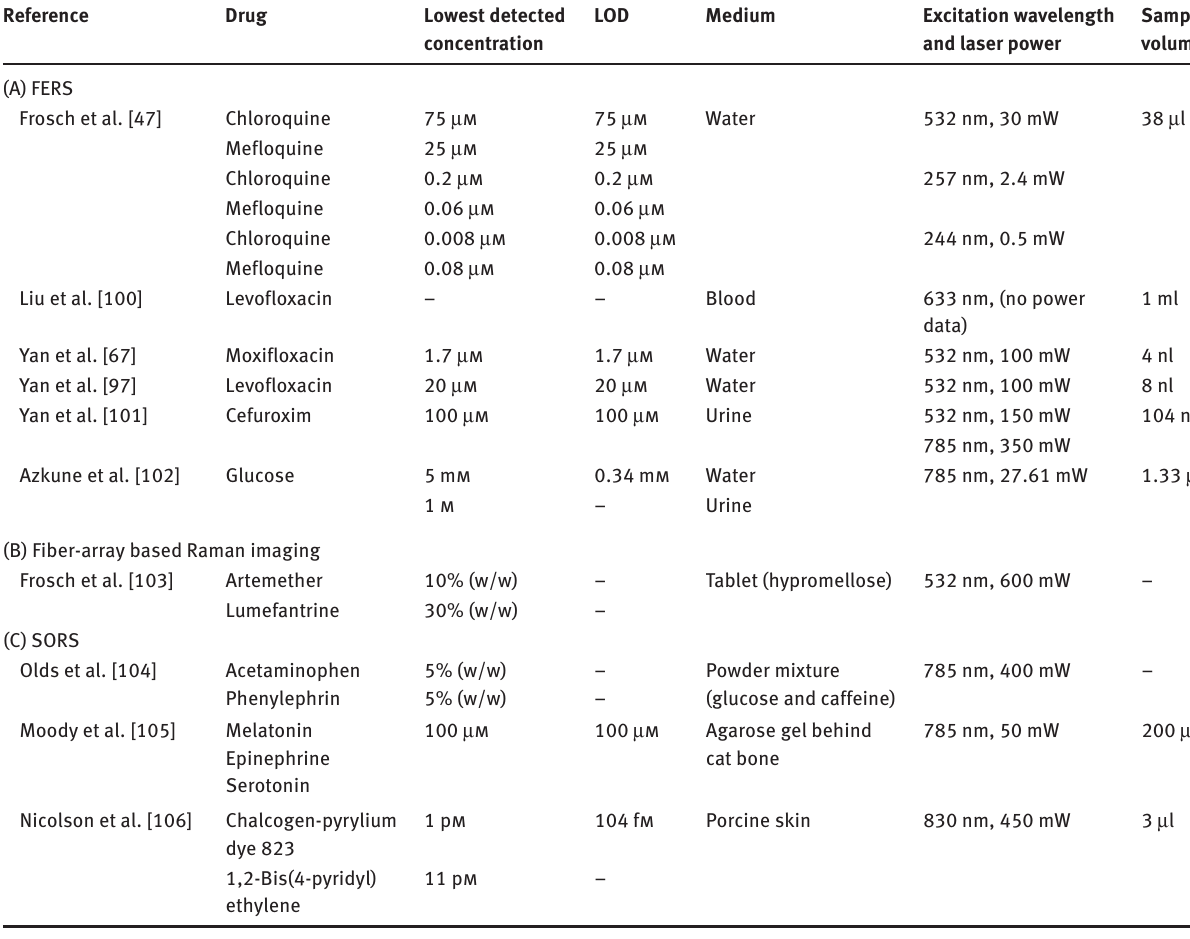
Table 2: Other Raman spectroscopic methods applied for pharmaceutical drug monitoring.